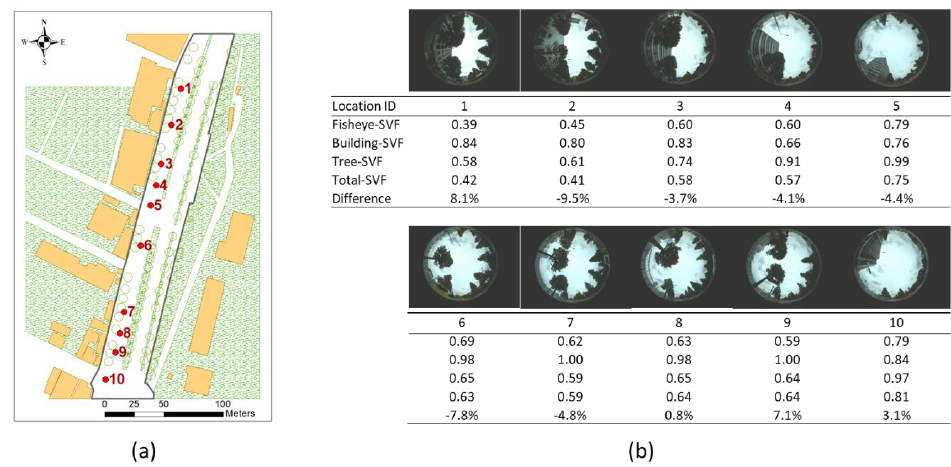
Figure 4. ( a ) SVF measurement location ( b ) fisheye measurement and estimate SVF comparisons.